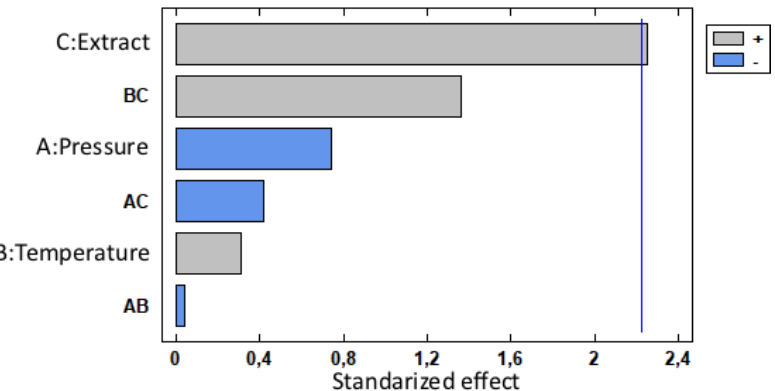
Figure 10. Pareto chart representing the ADC of the MLE-impregnated PLA.